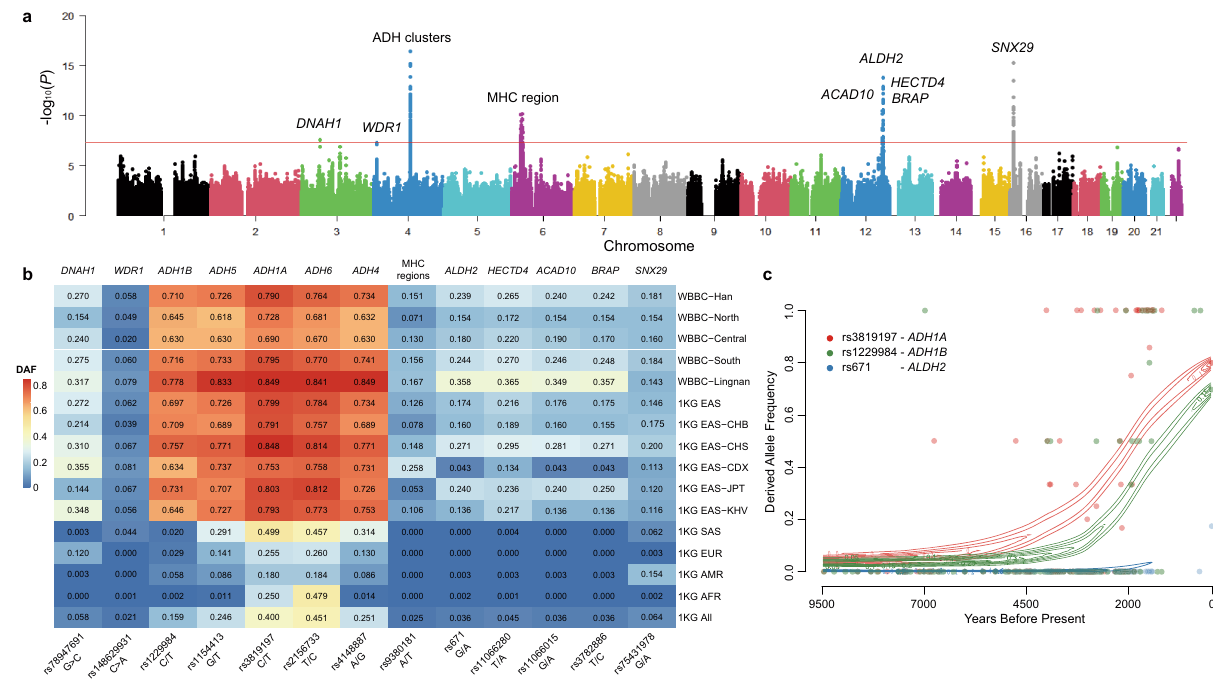
Fig. 2 Whole-genome-wide recent selection signatures of the Han Chinese population by singleton density score (SDS) analysis. a Manhattan plot of the natural selection signatures from the WGS data of the Han Chinese individuals. The y -axis represents the -log10 ( P ) of the two-tailed p values for standardized SDS z -scores. The horizontal red line indicates the signi fi cance threshold ( p < 5 × 10 − 8 ). b The derived allele frequency (DAF) of SNVs with signi fi cant selection signatures for different populations. The WBBC-Han is all the Han Chinese individuals sequenced by whole-genome sequencing (WGS) in the WBBC cohort. North, Central, South, and Lingnan are the four Han subgroups. EAS, SAS, EUR, AMR, and AFR come from the 1000 Genome Project (1KG). c The inferred allele frequency trajectory for the derived alleles at rs3819197, rs1229984, and rs671 over the past 9500 years from the ancient individuals of East Asia. The dot indicates the allele frequency in each generation (25 years/generation). Source data are provided as a Source Data fi